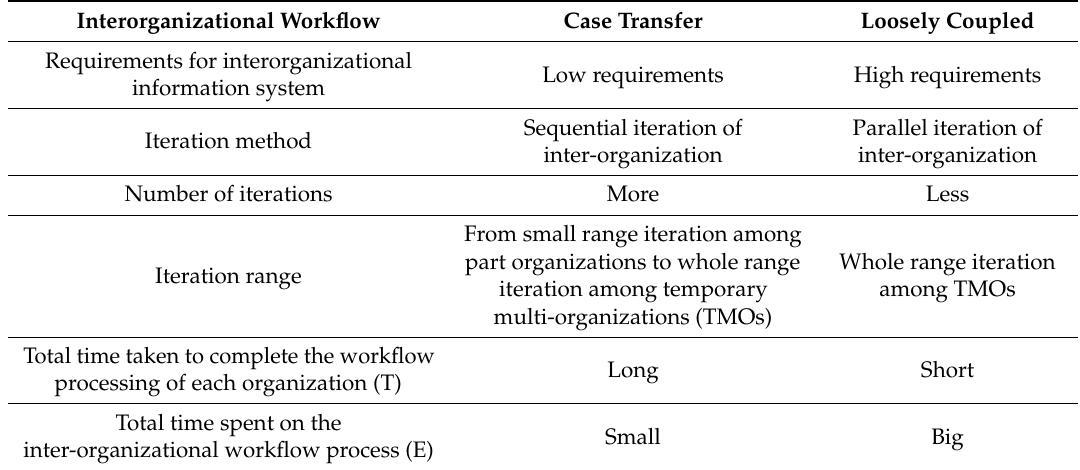
Contrastive analysis of role-based interorganizational workflows for two forms of interoperability: case transfer and loosely